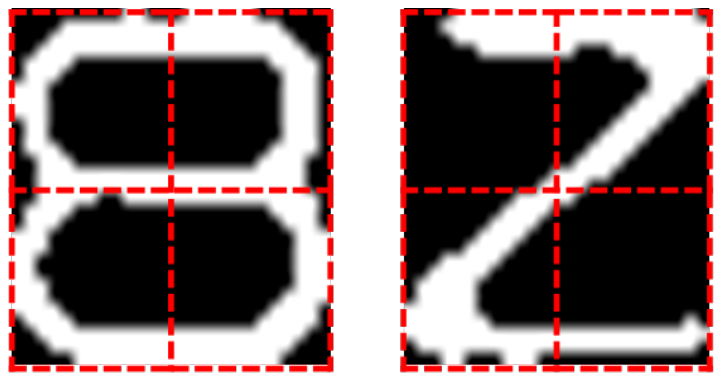
Figure 15. Character segmented into 2 × 2